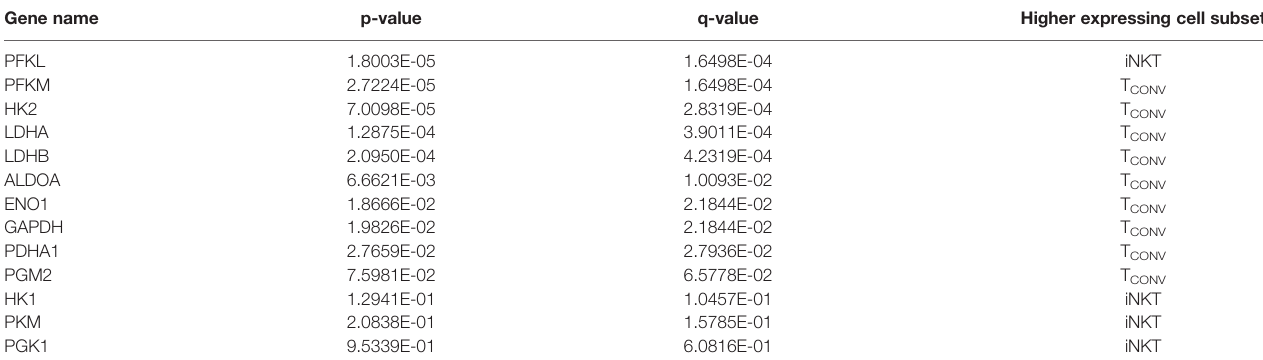
TABLE 1 | Glycolysis pathway gene set expression in stimulated iNKT cells and T CONV .